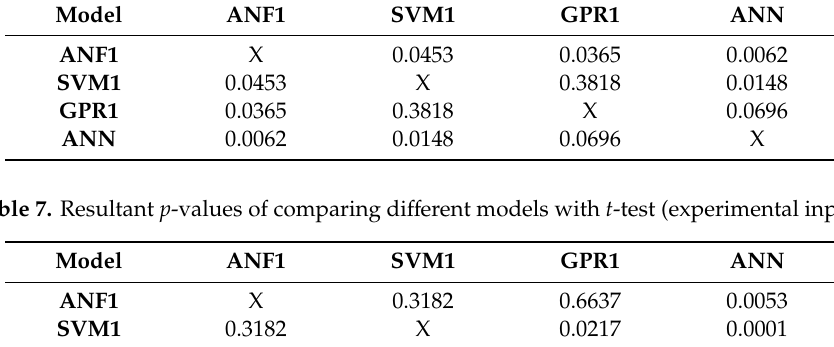
Table 6. Resultant p -values of comparing di ff erent models with t -test (numerical input). Table 7. Resultant p -values of comparing different models with t -test (experimental input).